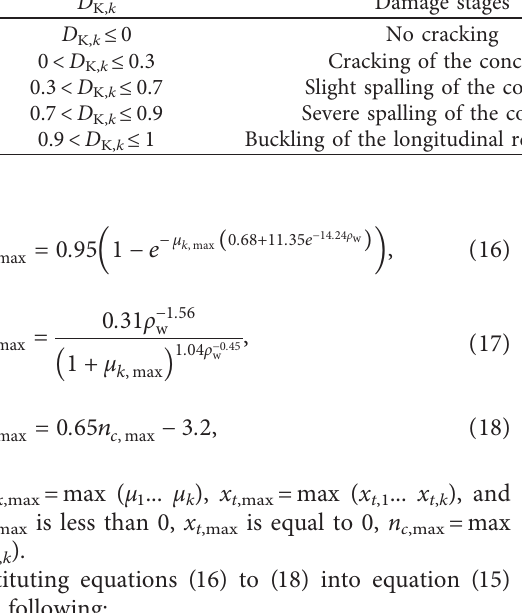
Figure 18: D E k - n k relations for specimens S1 to S9: (a) S1, S2, S7 and S8. (b) S4, S5 and S6. (c) S3 and S9. Table 5: Performance classification levels of the reinforced concrete members based on the value of D No. D K,